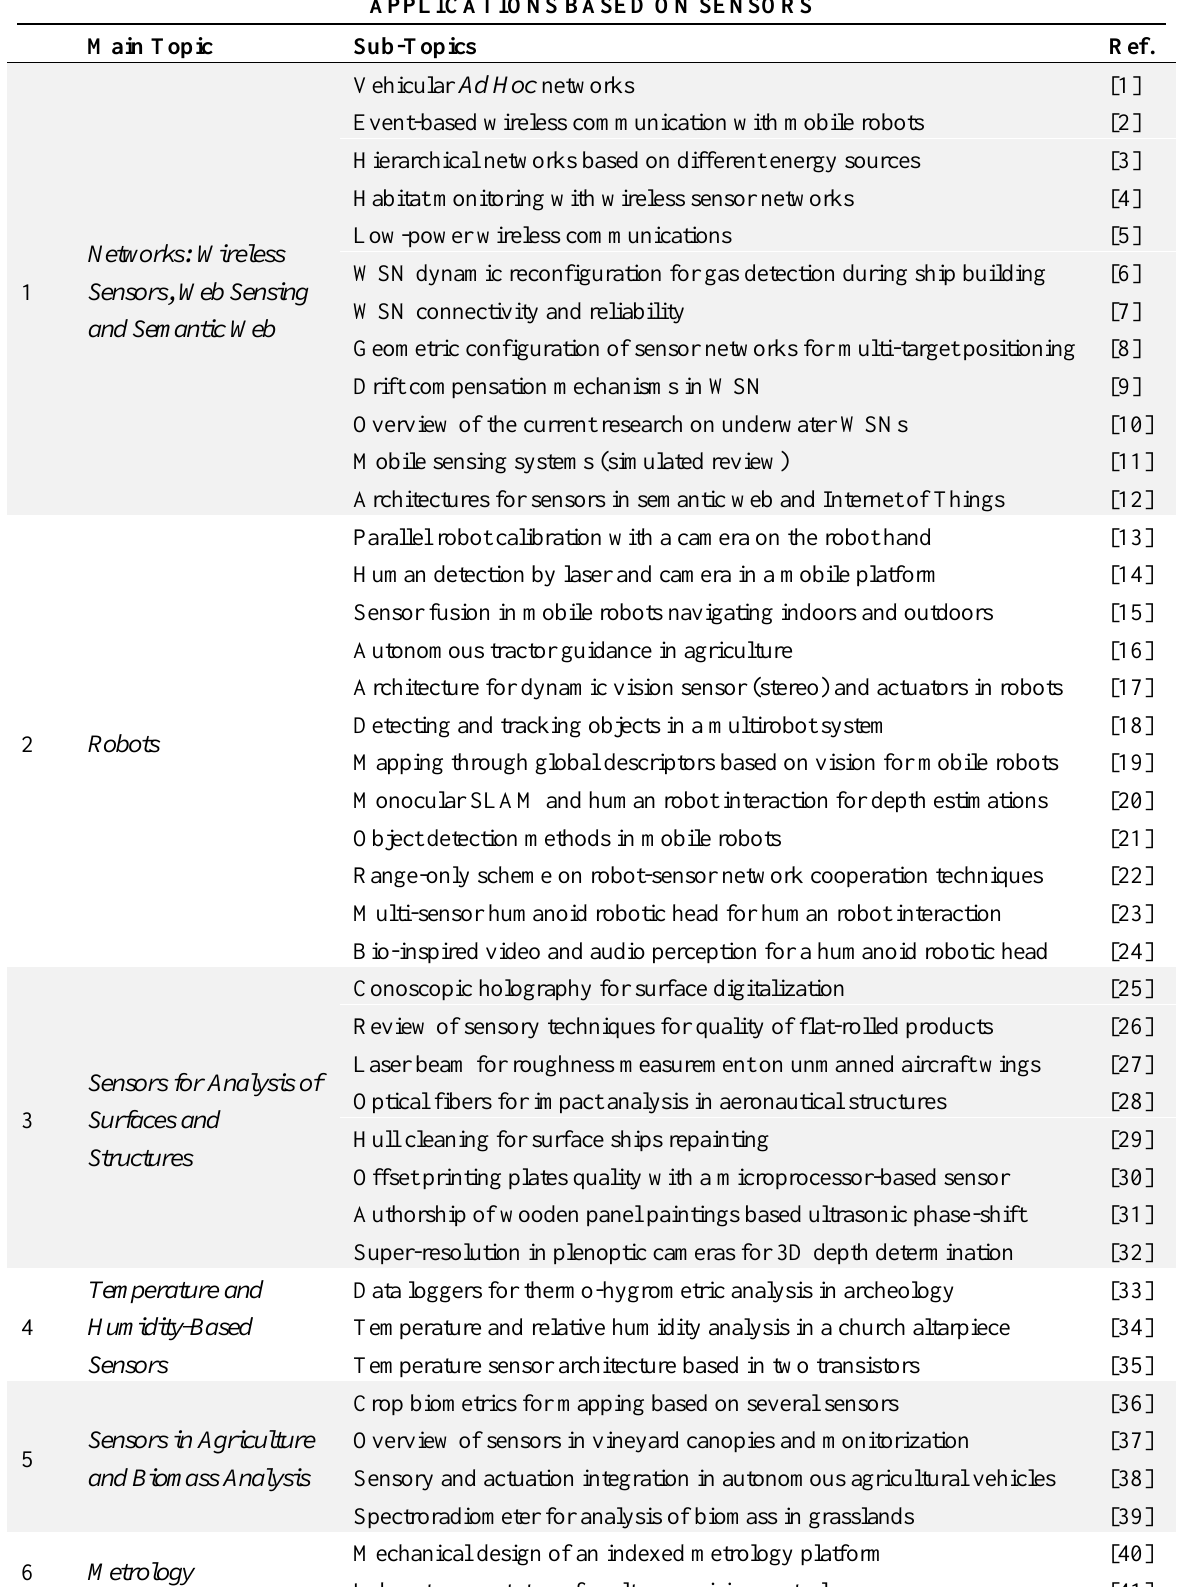
Table 1. Applications based on sensors: main topics and subtopics covered by the special